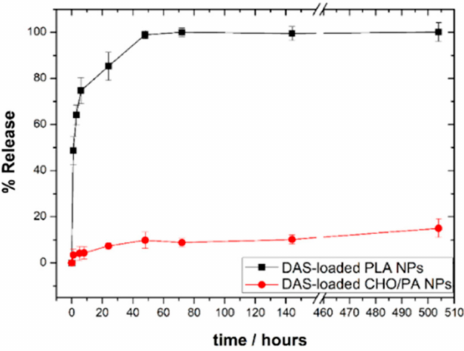
Figure 4. In vitro release profiles of DAS-loaded CHO / PA NPs and DAS-loaded PLA NPs at pH 7.4. Data are expressed as mean ± s.e.m. from at least three independent